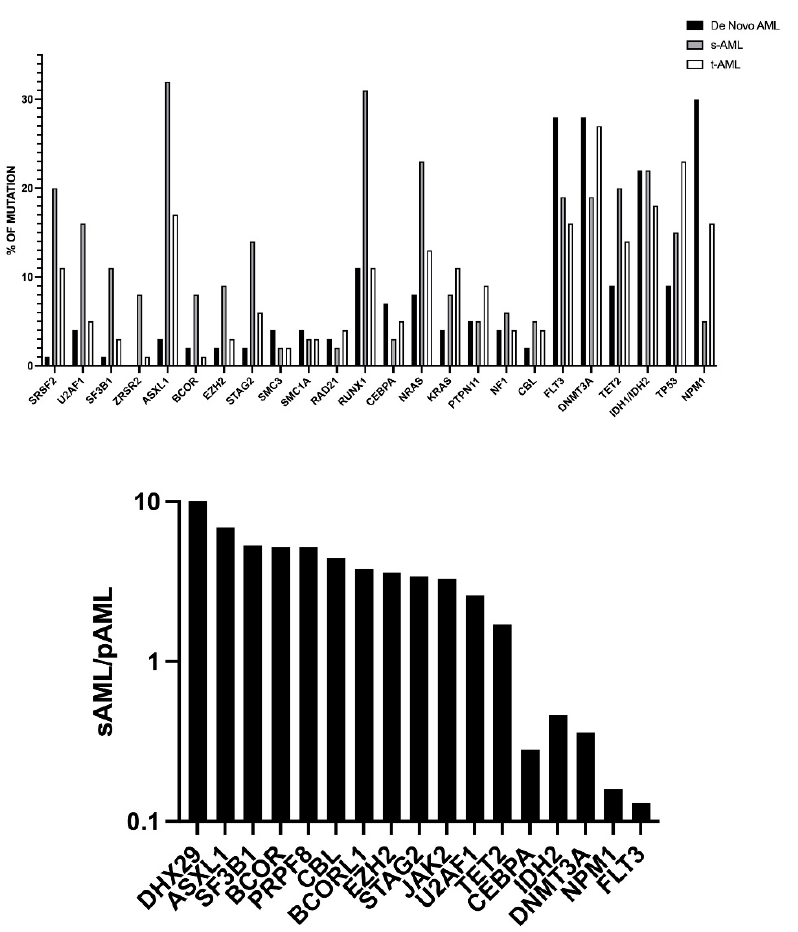
Figure 1. Frequency of main driver mutations in pAML, sAML, and tAML. Top Panel: frequency of recurrent gene mutations in adult pAML, sAML, and tAML. The Figure is based on the data reported by Lindsley et al., 2015 [8]. Bottom Panel: ratio between mutation frequency of some relevant driver gene mutations observed in sAML and in pAML. This graph reports the data relative to a set of genes whose mutations were clearly more frequent or less frequent in sAML compared to pAML.